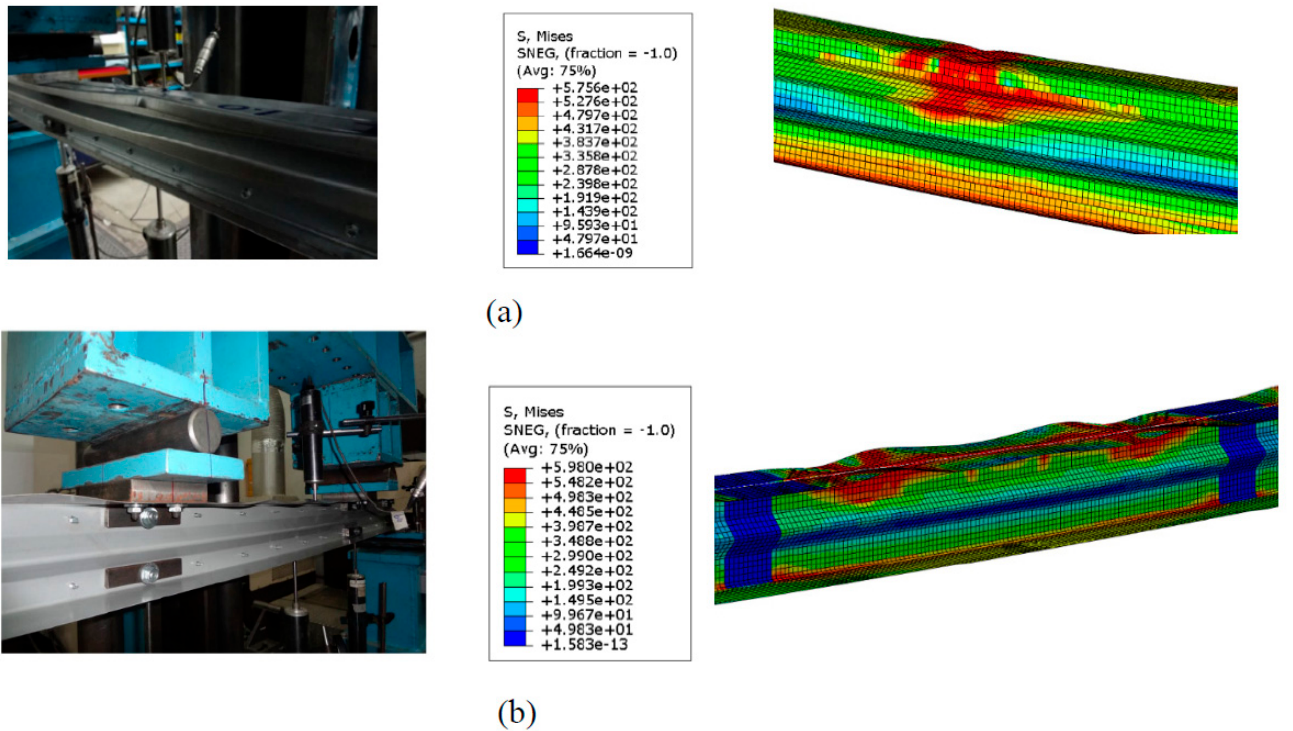
Figure 9. Failure mode comparison for ( a ) OI-1.0-B4 and ( b ) OV-0.48-B4 built-up channel sections with stiffeners [1,2].